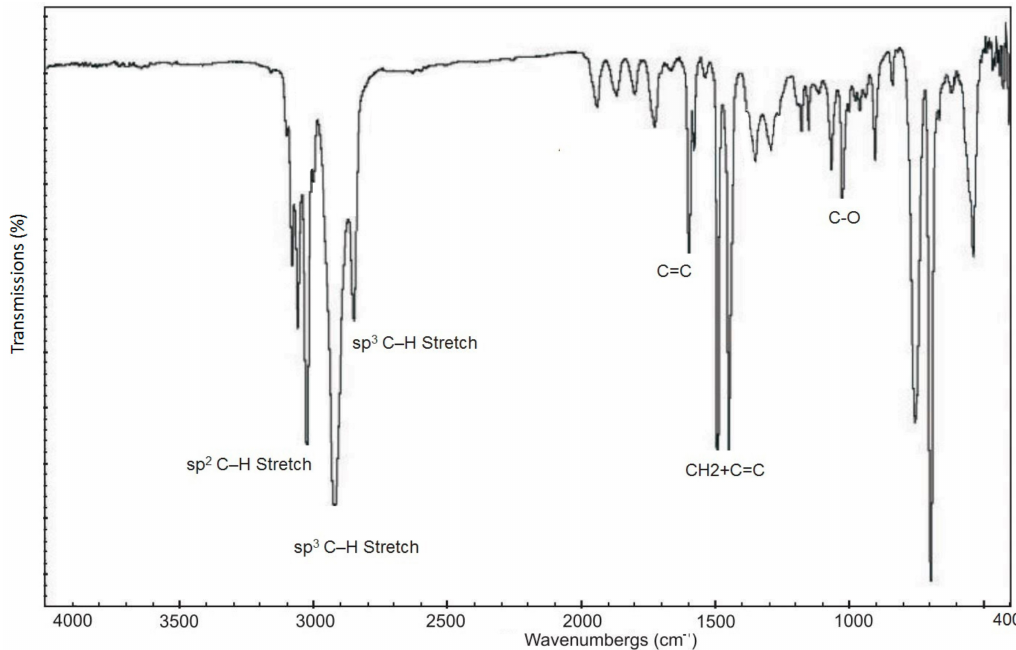
Figure 5. The FT-IR spectrum of undesired polymer